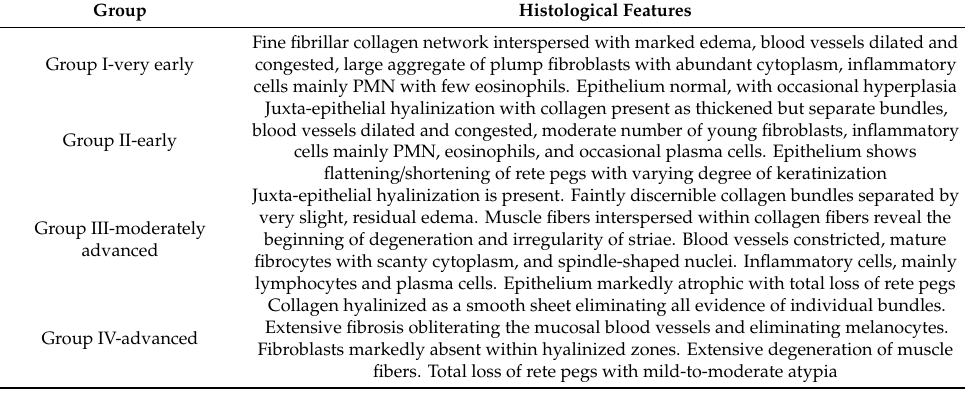
Table 2. Histological staging of oral submucous fibrosis